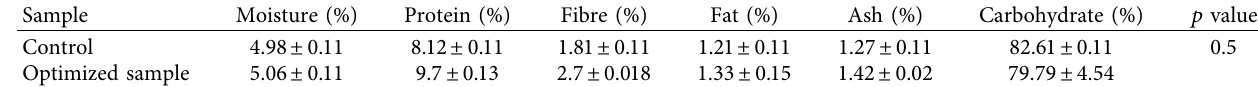
Table 2: Nutritional composition of optimized